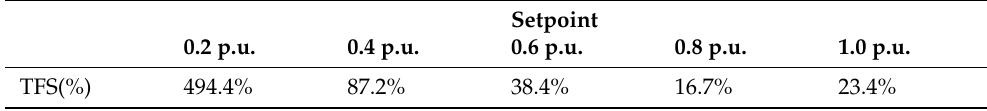
Table 2. TFS for different